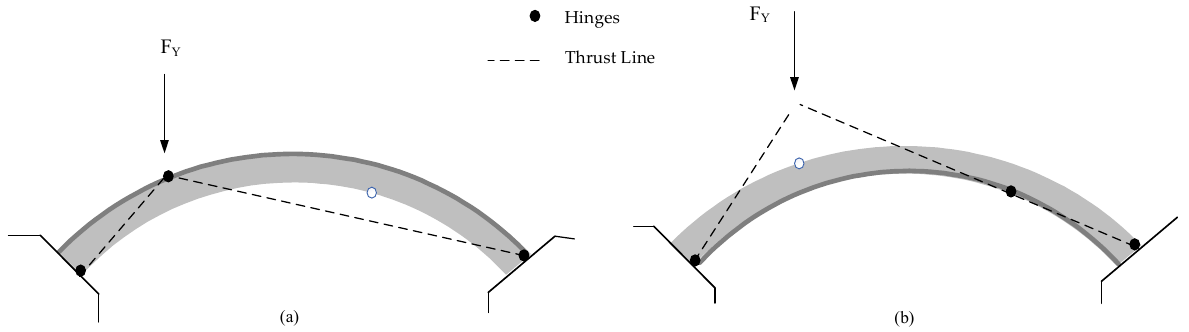
Figure 27. The thrust line and static scheme of arches strengthened at: ( a ) extrados, and ( b ) intrados [126].